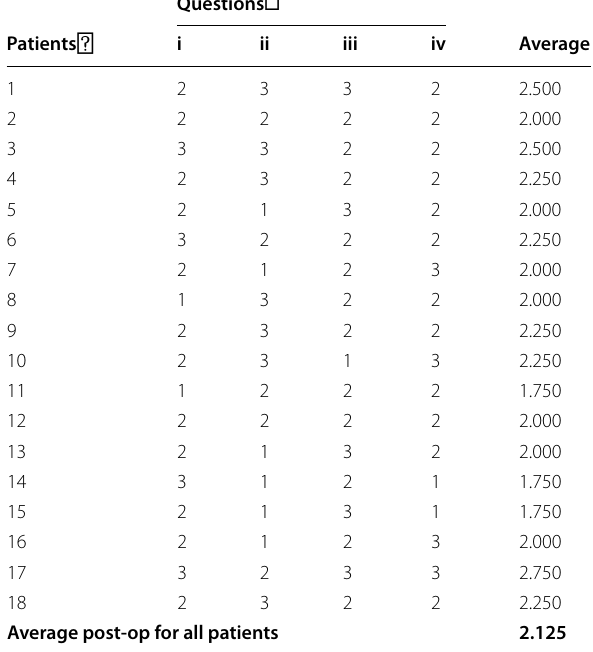
Table 4 AMAI rating post-op Questions